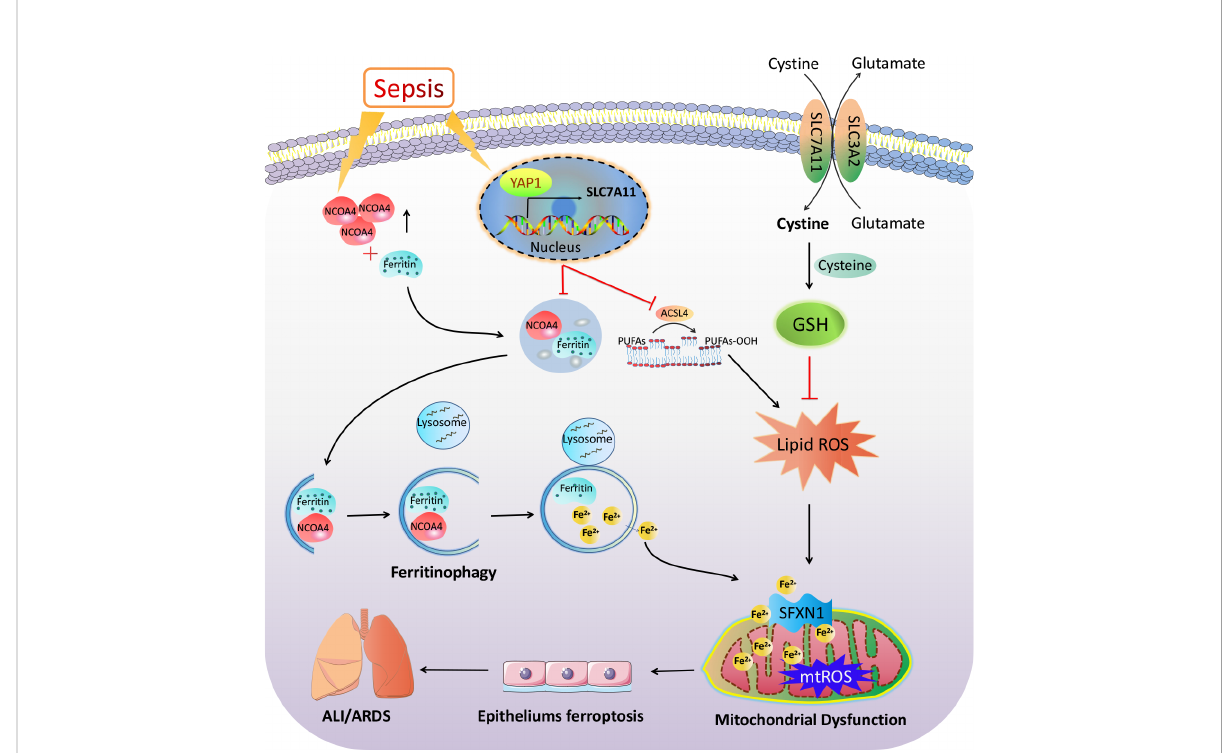
FIGURE 8 The mechanism illustration on the involvement of YAP1 in ferritinophagy and ferroptosis in sepsis-induced acute lung injury. Sepsis induces increased intracellular NCOA4 expression, which then has an interaction with ferritin and brings about the autophagic degradation of ferritin. YAP1 can suppress the degradation of ferritin into autophagosomes via inhibiting NCOA4-mediated ferritinophagy, then prevent ferrous iron from transporting into the mitochondria. YAP1 attenuates the accumulation of mitochondrial reactive oxygen species and lipid peroxidation and contributes to protecting mitochondrial function and repressing ferroptosis. Therefore, we conclude that YAP1 is involved in sepsis-induced acute lung injury by regulating the process of ferritinophagy-mediated